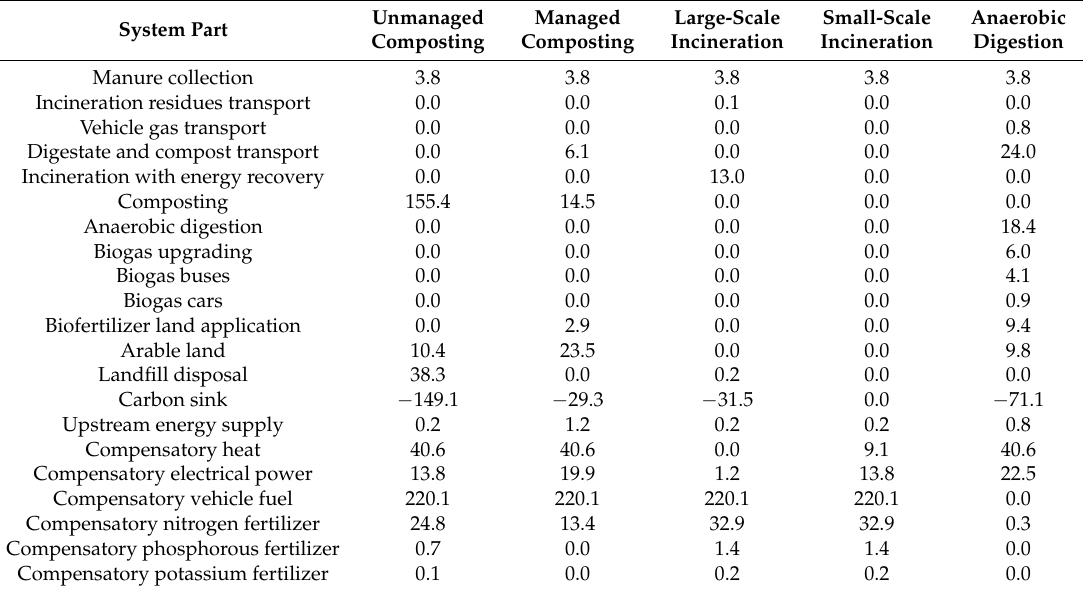
Table B2. Global Warming Potential (Tonne CO 2